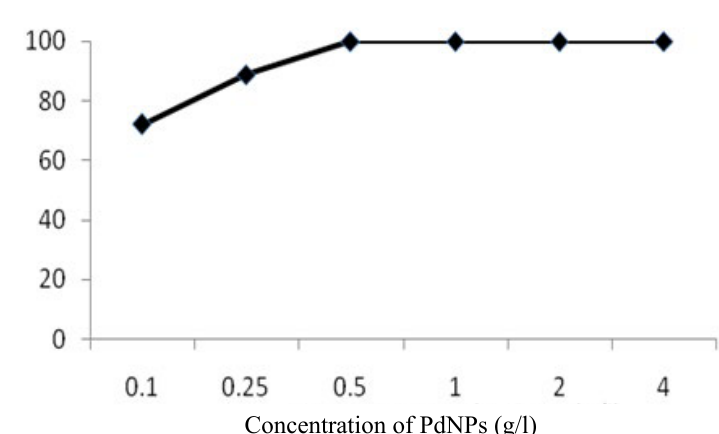
Fig. 4. Effect of adsorbent dose on